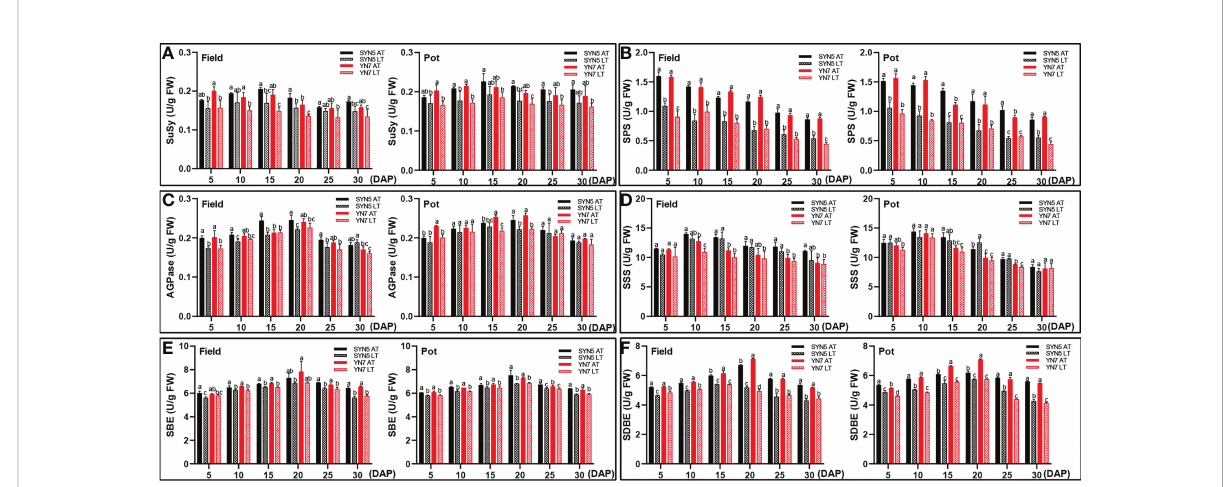
FIGURE 4 Effect of post-silking LT on the enzymatic activities of soluble sugar and starch synthase in grains during grain fi lling stage. (A) , SPS (sucrose phosphate synthase); (B) , SuSy (sucrose synthase); (C) , AGPase (ADP-glucose pyrophosphorylase); (D) , SSS (soluble starch synthase); (E) , SBE (starch branching enzyme); (F) , SDBE (starch-debranching enzyme). Error bars denote standard errors from three replicates, and different letters above the bars in same sampling date are signi fi cantly different at P <